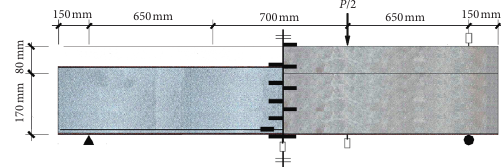
Figure 5: Test setup and measuring points layout.